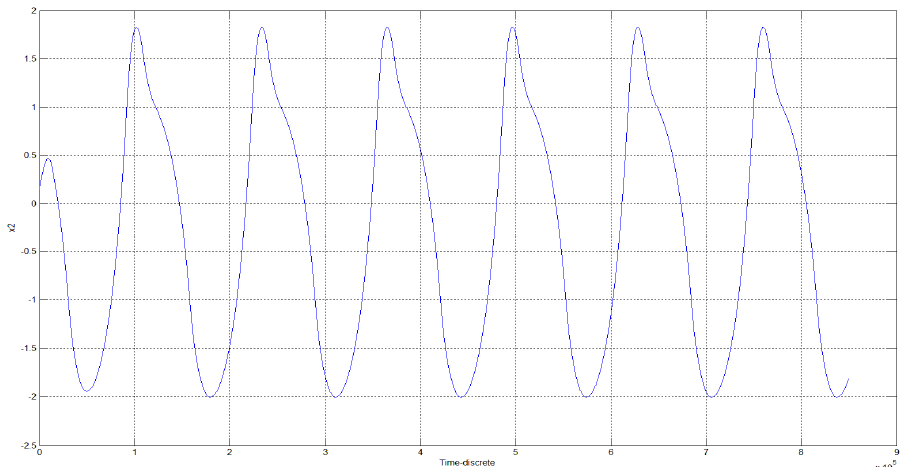
Figure 7. The reference PPG compliant dynamic of the proposed Reaction-Diffusion Model (RD-M) (x 2 variable) .